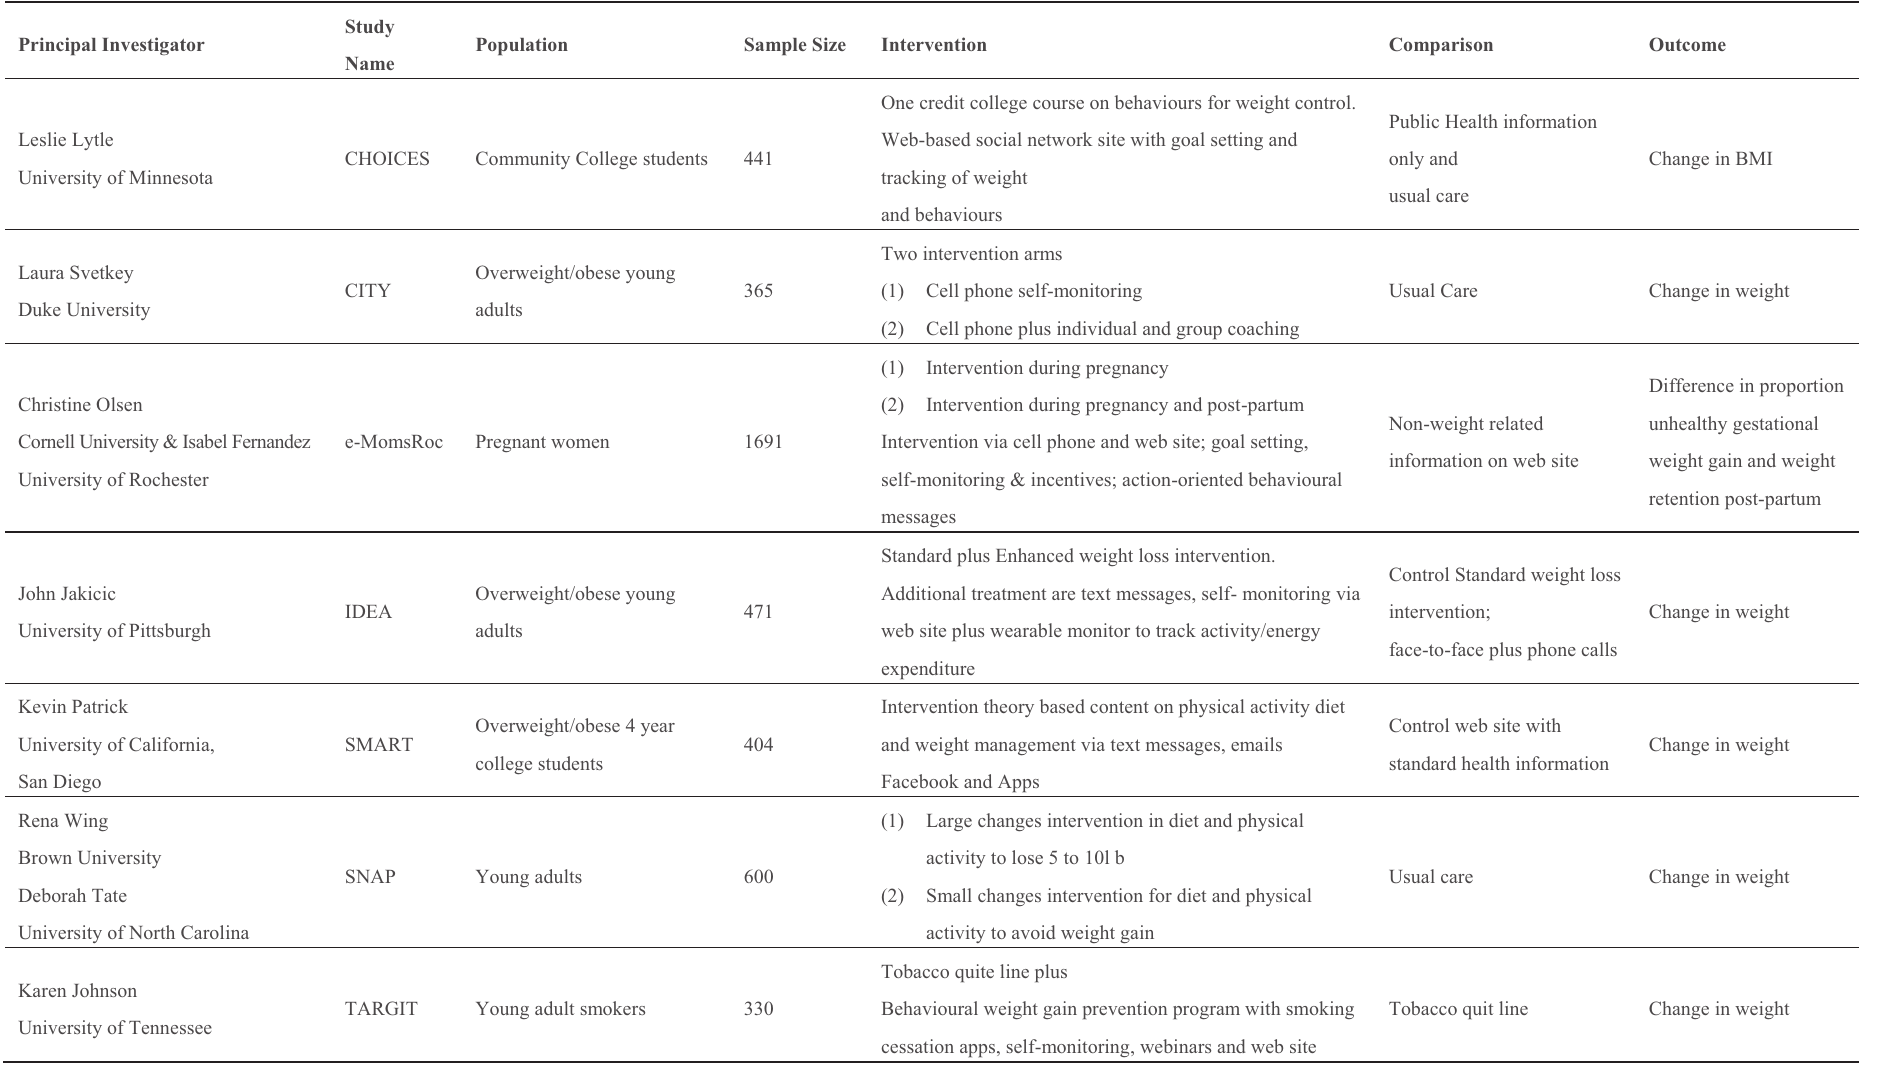
Table 1. Outline summary of the Early Adult Reduction of weight through LifestYle intervention (EARLY) trials being conducted in the US [48]. Principal